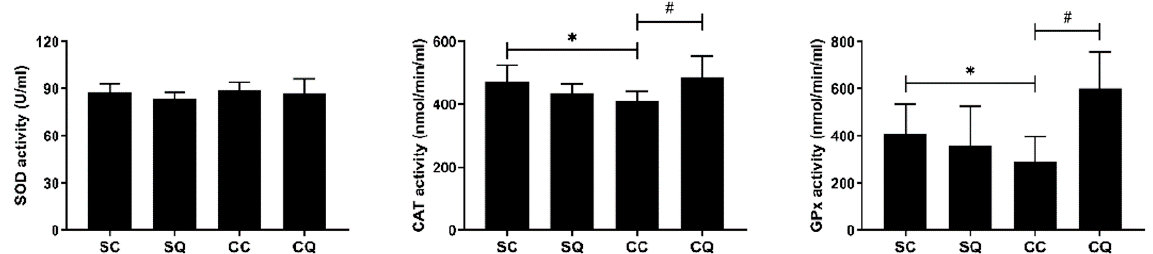
Figure 6. Testicular antioxidant activity in sham surgery and CKD surgery mice treated with vehicle (corn oil) or CoQ10. SC: sham surgery mice with vehicle; SQ: sham surgery mice with CoQ10; CC: CKD surgery mice with vehicle; CQ: CKD surgery mice with CoQ10. Data are expressed as the mean ± SD ( n = 4–6 per group). * p < 0.05 denotes a significant difference between the sham surgery and CKD surgery groups (SC vs. CC and SQ vs. CQ); # p < 0.05 denotes a significant difference between the vehicle treatment and CoQ10 treatment groups (SC vs. SQ and CC vs. CQ). CoQ10, coenzyme Q10. SOD, superoxide dismutase; CAT, catalase; GPx, glutathione peroxidase.